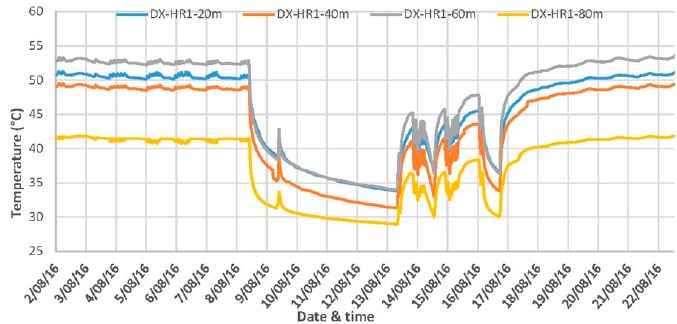
Figure 7. Heat rejection (HR) boreholes temperatures of DX system with different depths as indicated between August 1 and August 22, 2016.